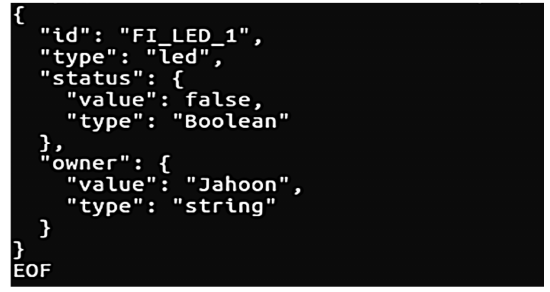
Figure 10. Implementation testbed.